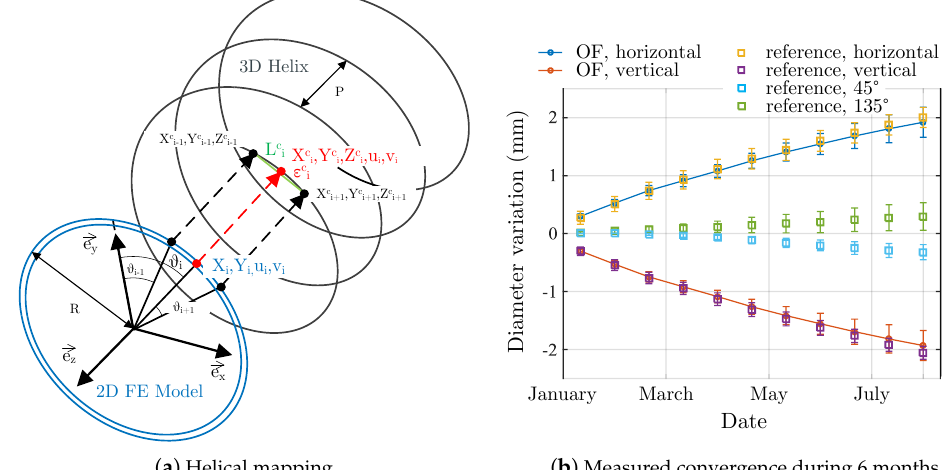
Figure 12. Mapping and first